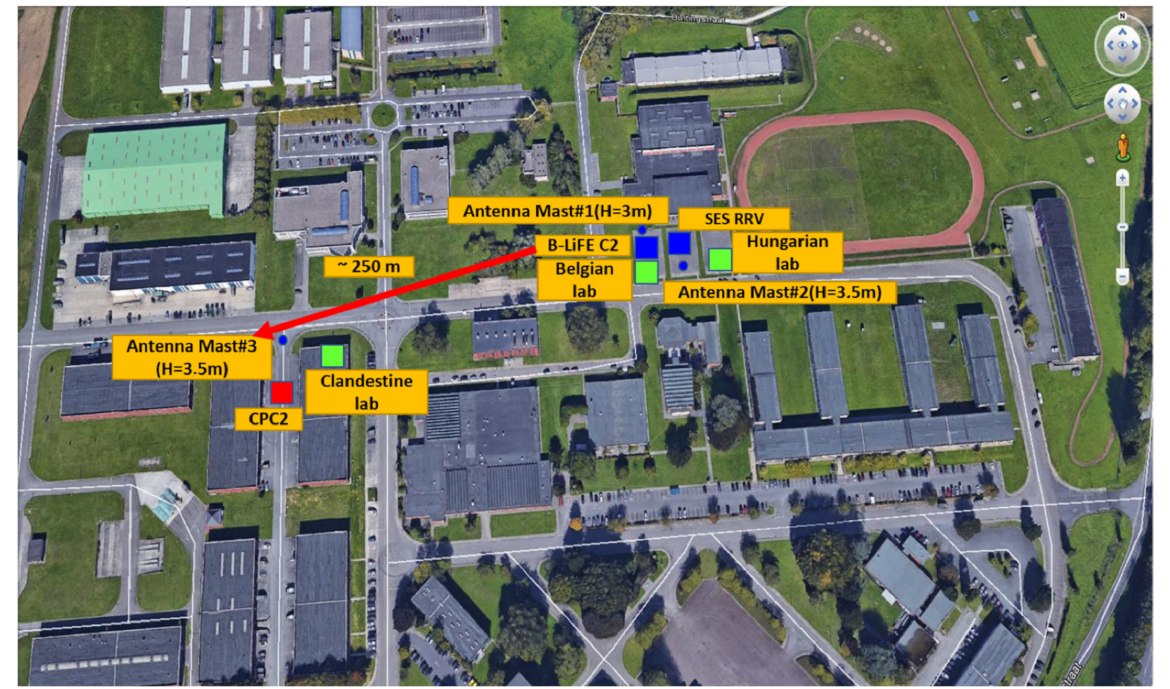
Figure 6. Global view of the “ Bio-Garden ” Exercise, conducted in the military domain Major Housiau, Vilvoorde, Belgium. This international exercise t” ok place in the framework of the implementation of both ESA/ IAP/ARTES B-LiFE and Horizon 2020 eNOTICE research